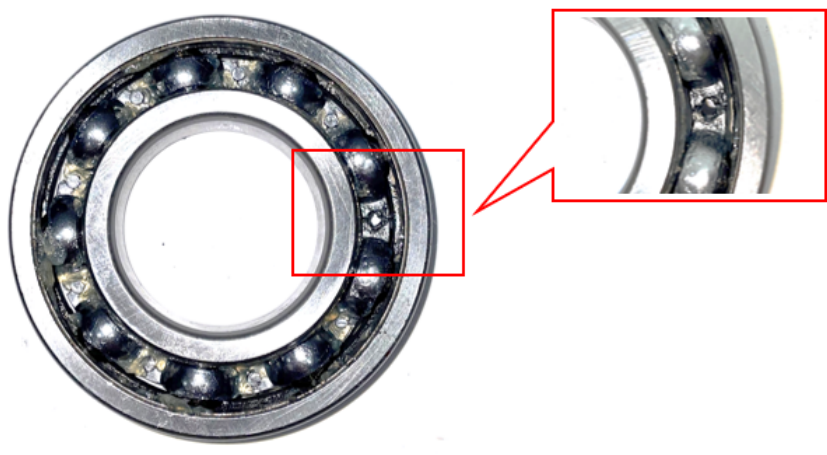
Figure 1. Damaged cage in rolling bearing.